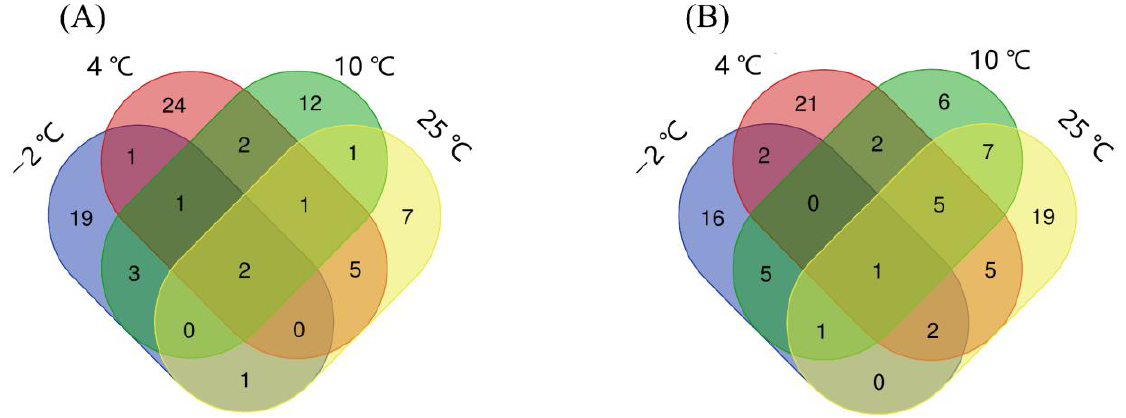
Figure 3. Venn diagrams of differentially abundant peptides. Upregulated peptides ( A ); downregulated peptides ( B ).